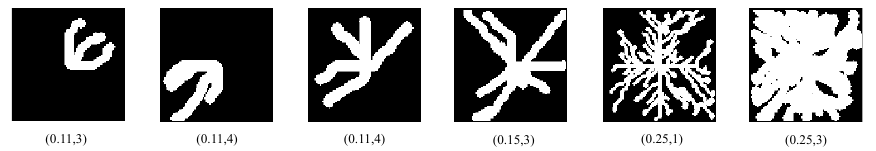
Figure 1. Example of map generation using Algorithm 1. The first parameter is the randomness index required by the automaton Pe (the higher the index is, the greater the generation of roads). The second parameter indicates the intensity of a morphological expansion applied to the map for smoothing D . The map size is 15 m × 15